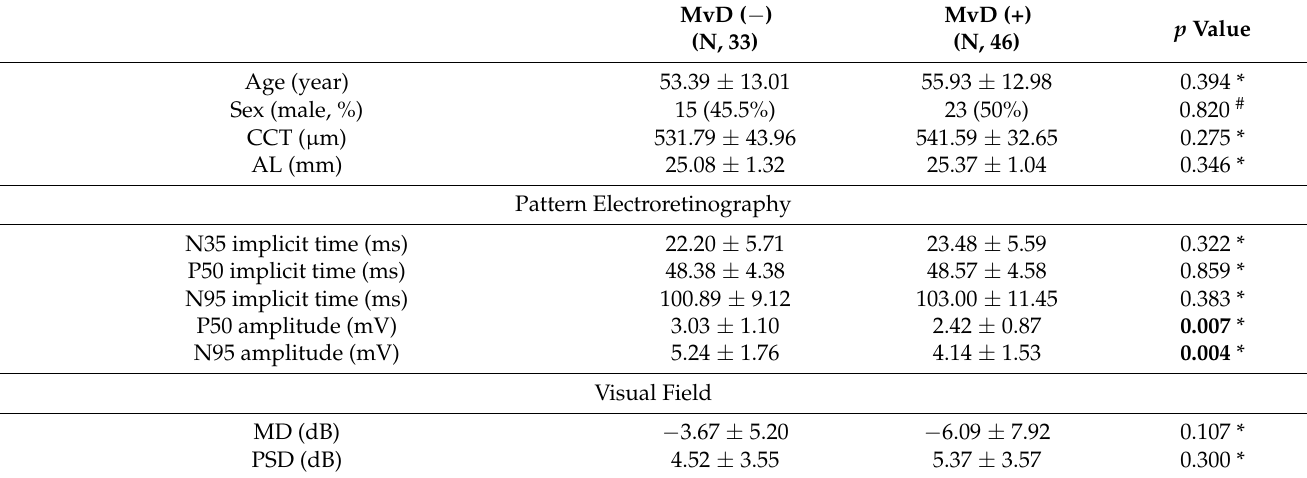
Table 2. Comparison of Patient’s Characteristics in terms of Presence of Circumparapapillary Choroidal Microvasculature